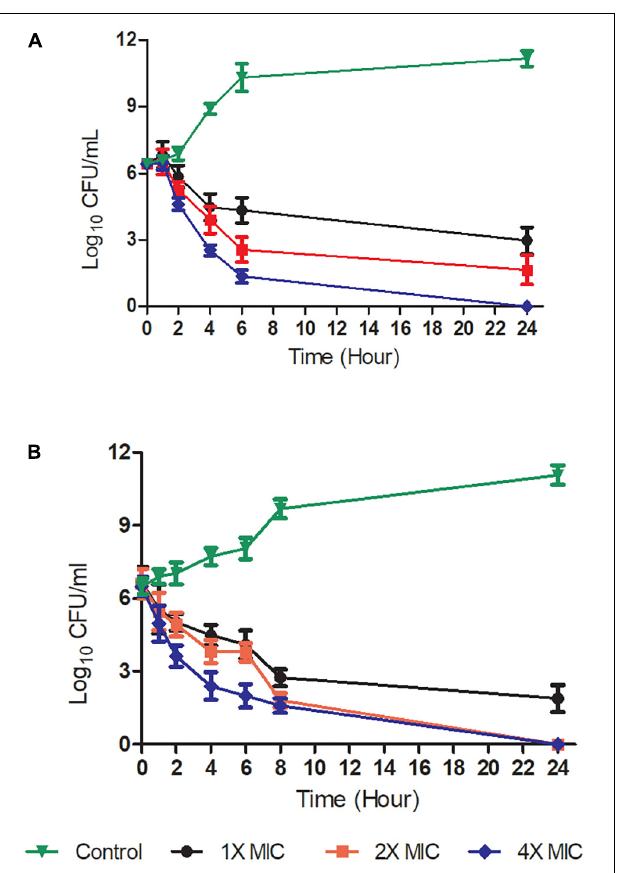
FIGURE 2 | Time-kill kinetics at a range of concentrations of Teixobactin derivative 4. Gram-positive bacteria [ S. aureus ATCC 29213 (A) and B. subtilis ATCC 6051 (B) ] were challenged with compound 4 at 1X, 2X, and 4X MIC levels. The experiment was performed in triplicate ( n = 3). Data was presented as mean and standard deviation of three independent replicates, analyzed with one-way ANOVA followed by Dunnett’s test to determine the significance relative to the untreated bacteria ( P <